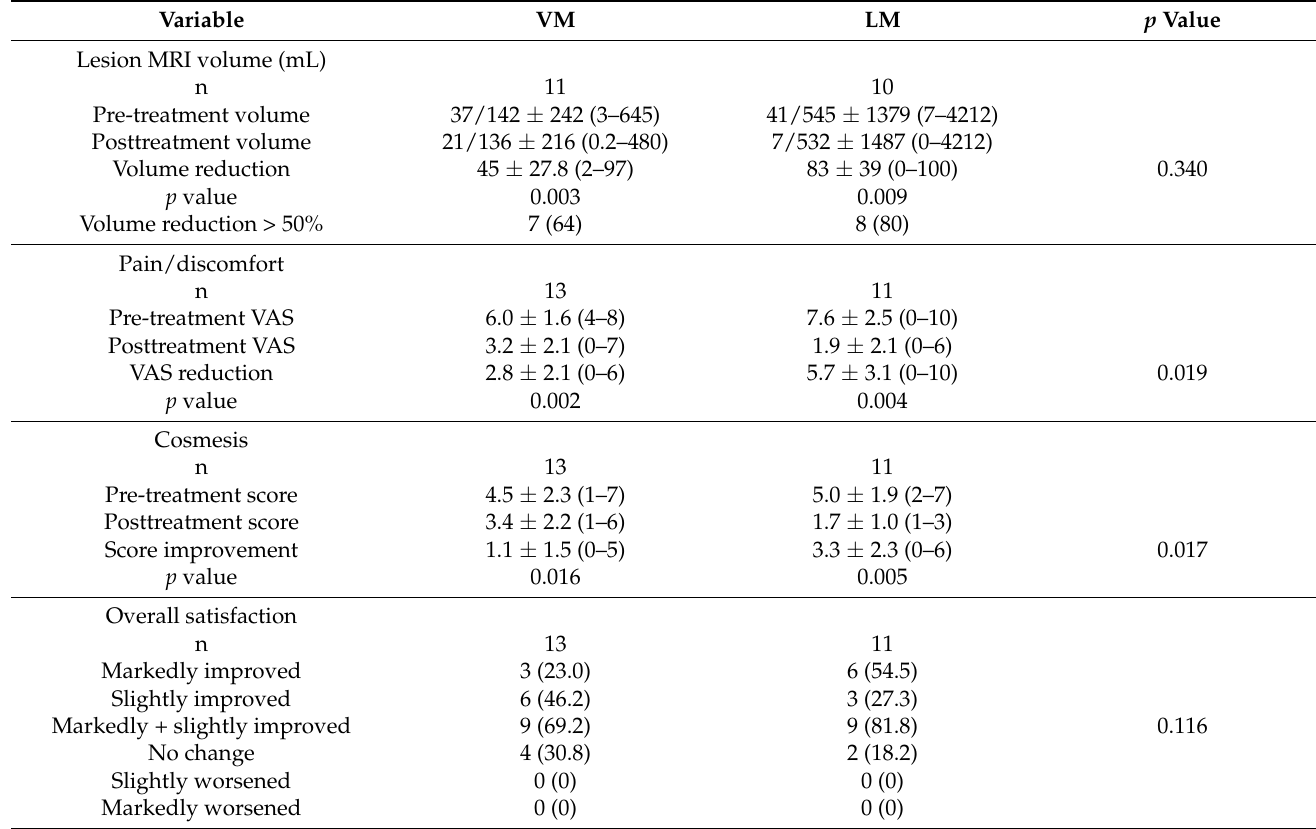
Table 2. Radiological results, clinical outcomes and overall